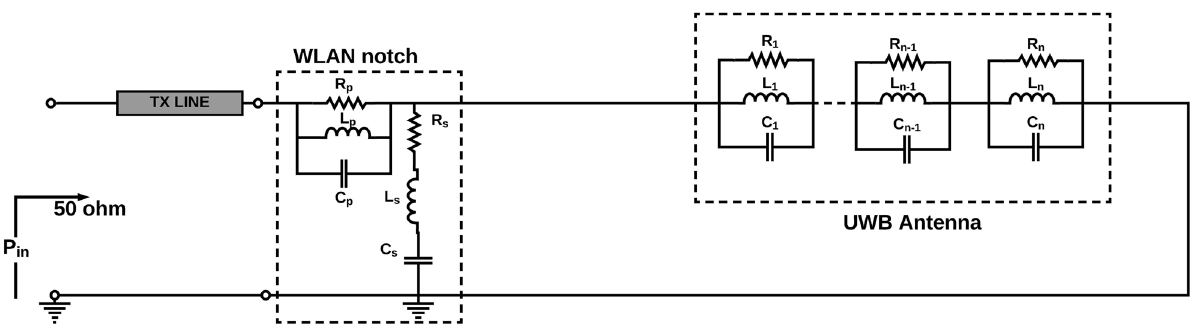
Figure 7. The lumped equivalent circuit model of WLAN(5 GHz) band notch It can be seen from the EM model and the lumped circuit model S-parameters are almost the same. Also, it is witnessed that at the notch band the S11 is greater than -2dB for both EM model and equivalent circuit model due to impedance mismatch. Equation (6) used to achieve band notch at WLAN band. Hence, it is clear from the reflection coefficient the WLAN band notch is effectively achieved by using an L-shaped stub.